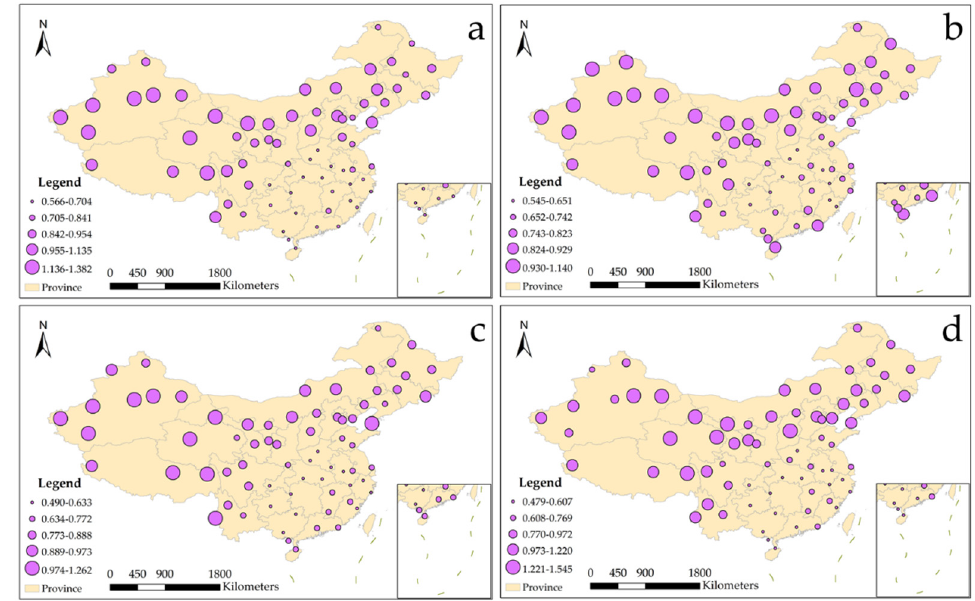
Figure 8. Geographical changes in coefficient c for the 72 stations in the Sen Model in spring ( a ), summer ( b ), autumn ( c ) and winter ( d ).